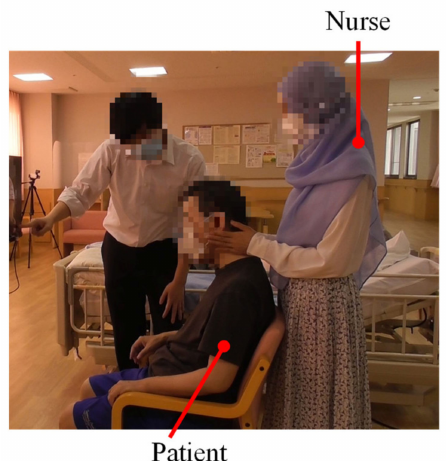
Figure 5. The nurse with the